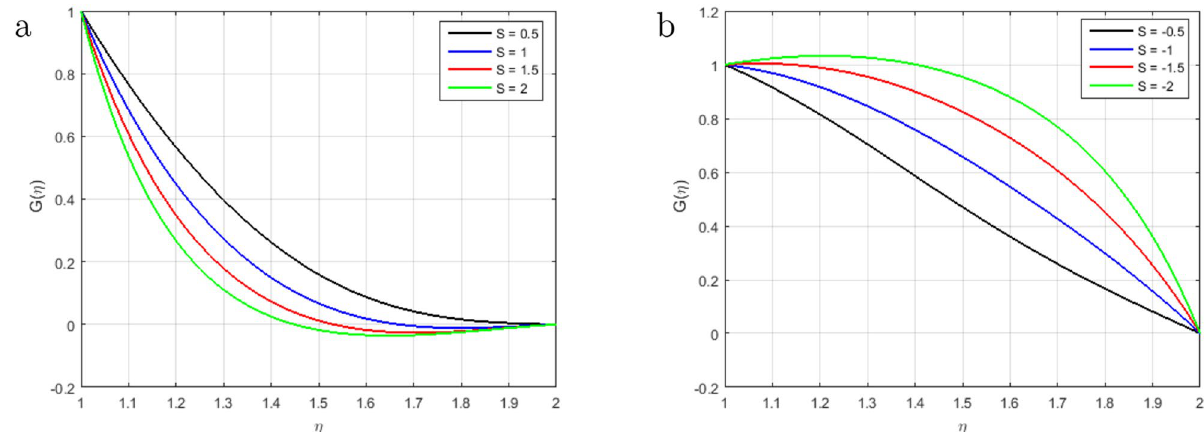
Figure 6. Influence of G (η) for S > 0 , S < 0 and fixed values of Re m = 2.5, M = 0.5, Pr = 3.2, Hs = 1.2, C 1 = 0.4, Sc = 1.4, Sr = 1.5 .